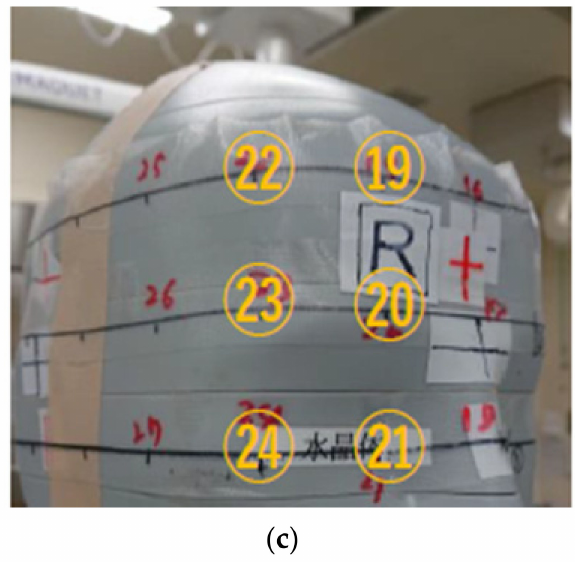
Figure 4. The 24 measurement points on the head of the phantom simulating the physician: ( a ) frontal view; ( b ) left lateral view; ( c ) right lateral view. Twenty-four dosimeters were attached to the points marked on the phantom’s surface (left eye: No. 3 (cid:13) , right eye: No. measurement points was 3 cm.